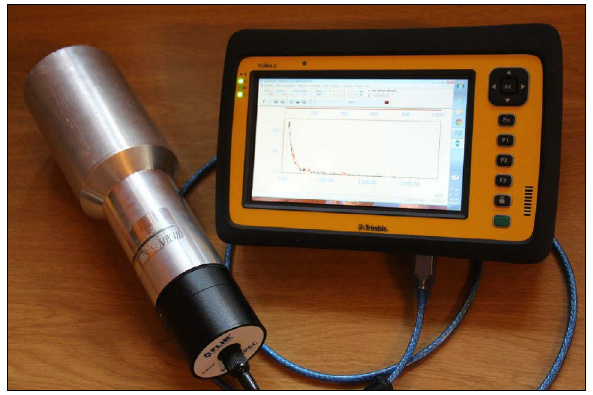
Figure 1: The NaI(Tl) scintillation detector with a 7.62 x 7.62 cm crystal coupled to the scintiSPEC Multi-Channel Analyser and connected to the Trimble Yuma Rugged tablet computer via the USB connection.